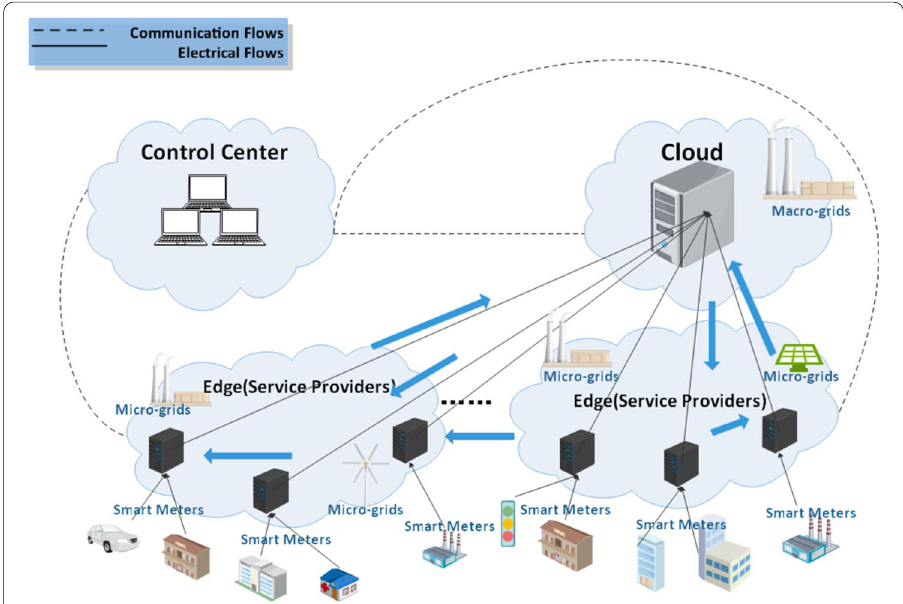
Fig. 2 Edge based smart grid